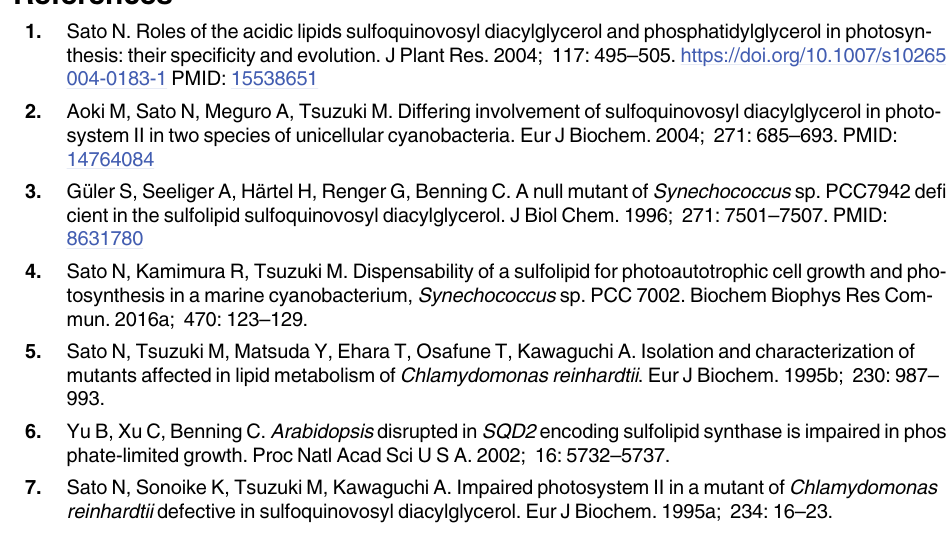
S1 Table. Primer sets used for semi-quantitative PCR analysis of transcripts as to the genes for SQDG synthesis. S1 Fig. SDS-PAGE of the soluble fraction of Synechocystis cells starved for S. Note that PBS subunits were not decreased in their abundance during